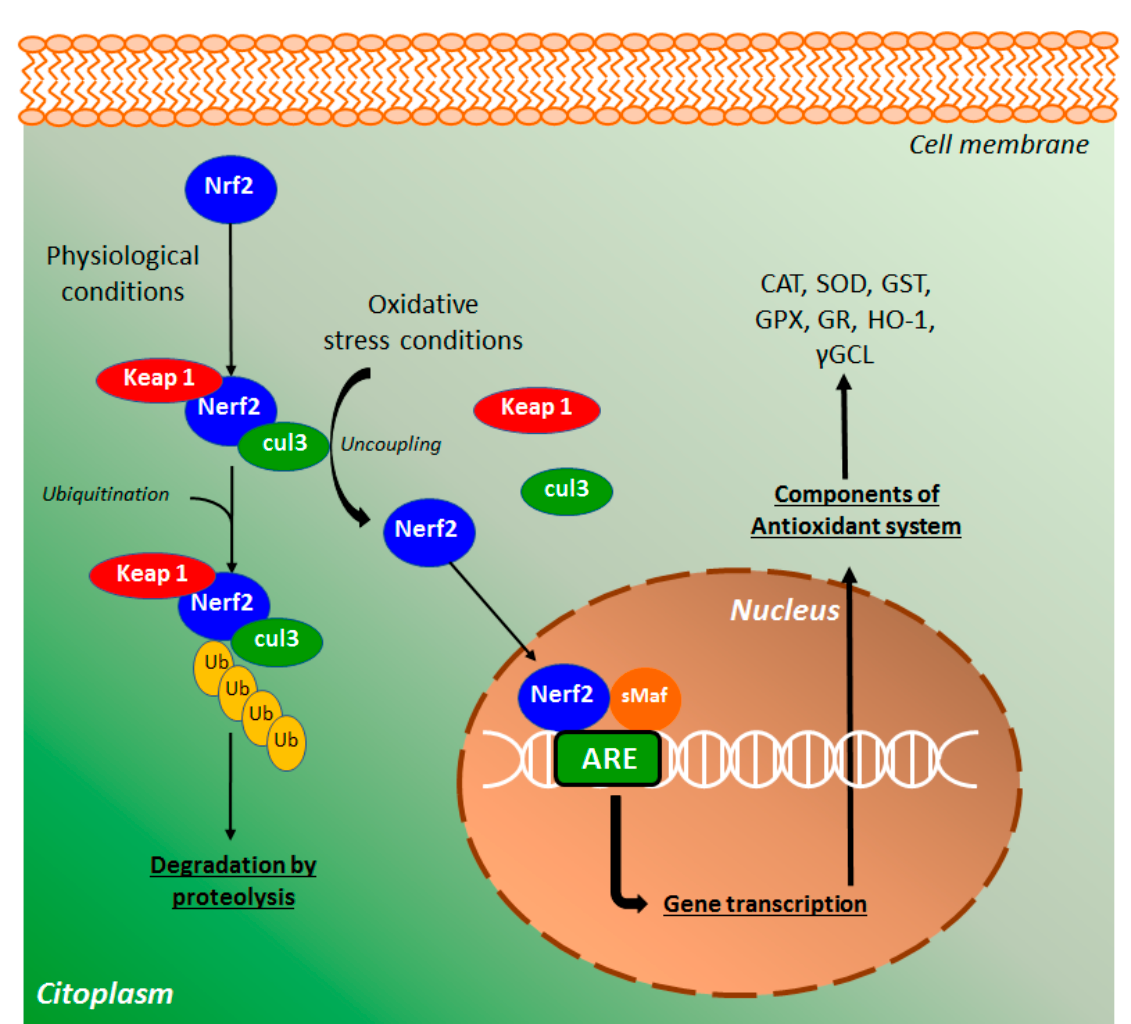
Figure 7. The nuclear factor erythroid 2 (NEF2)-related factor 2 (Nrf2) signaling pathway of oxidative stress. ARE, antioxidant element of response; CAT, catalase; cul3, cullin 3; GST, glutathione S-transferase; GPX, glutathione peroxidase; GR, glutathione reductase; HO-1, heme-oxygenase 1; Keap1, Kelch-like ECH-associated protein 1; Nrf2, nuclear factor erythroid 2-related factor 2; sMaf, small Maf proteins; Ub, ubiquitin; γ GCL, γ -glutamylcysteine ligase. In these oxidative processes, the following activities were reported: A. Upregulation of Nrf2 by esculetin, 4-methylesculetin, daphnetin, and esculin.